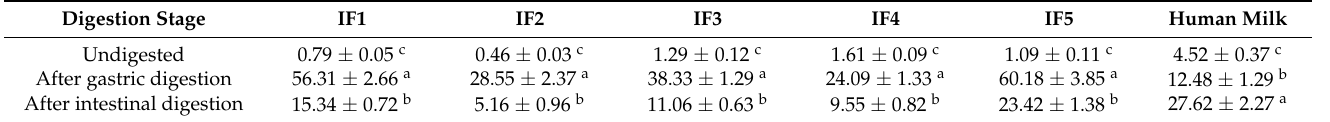
Table 1. Average particle size ( µ m) of fat globules in infant formulas and human